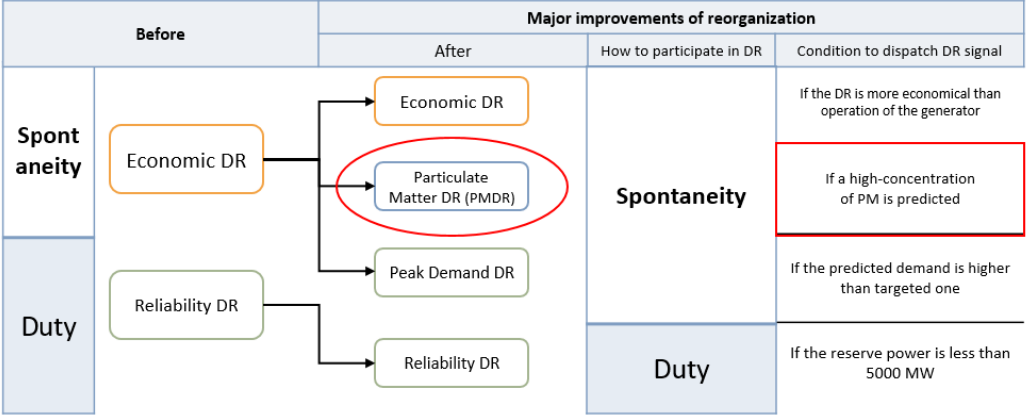
Figure 1. Reorganization of the demand response (DR) program in Korea.